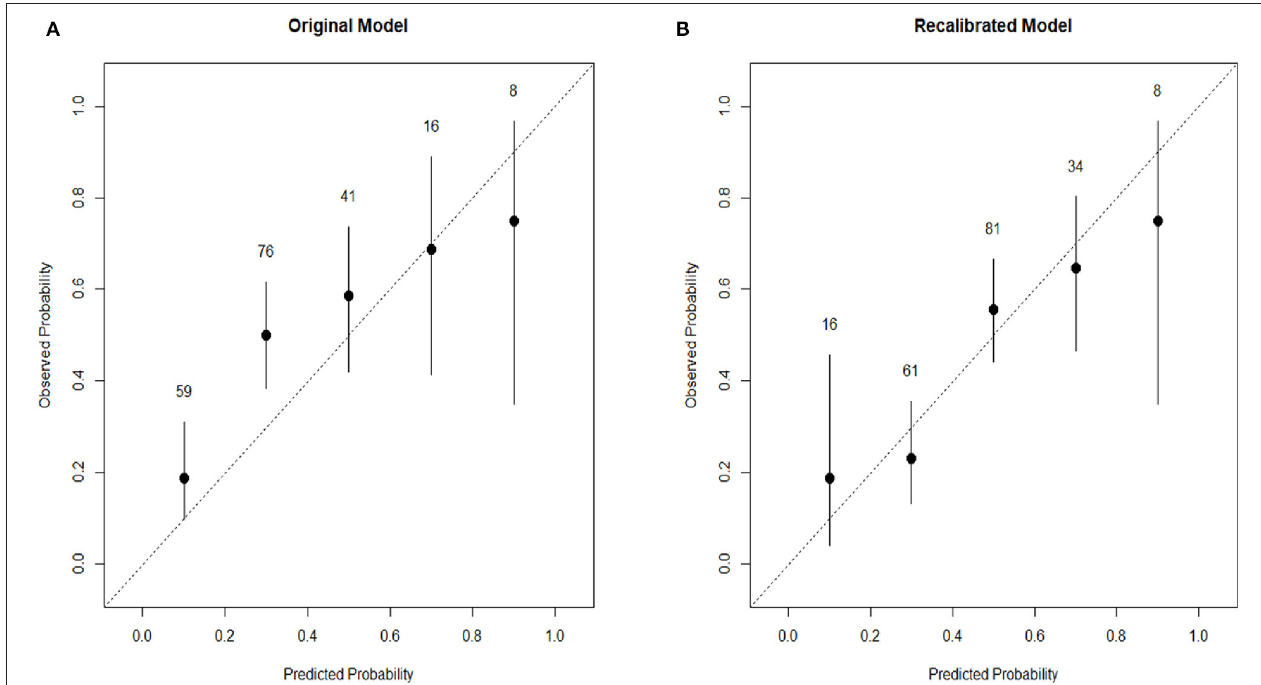
FIGURE 4 | (A) External calibration plot for Jinyintan dataset based on the original nomogram. (B) External calibration plot for Jinyintan dataset based on the recalibrated nomogram. The nomogram was recalibrated by the intercept and slope framework as originally proposed by D.R. Cox. 8 The plots are grouped into five bins based on their predicted probabilities, and then the bin prevalence (the ratio of plots in this bin with observed number of severe/critical COVID-19 vs. the total number of plots in this bin) is calculated for each bin. The confidence interval for each bin is also plotted, and the total number of plots is labeled above each the bin. Confidence intervals are calculated for the binomial bin counts using the F